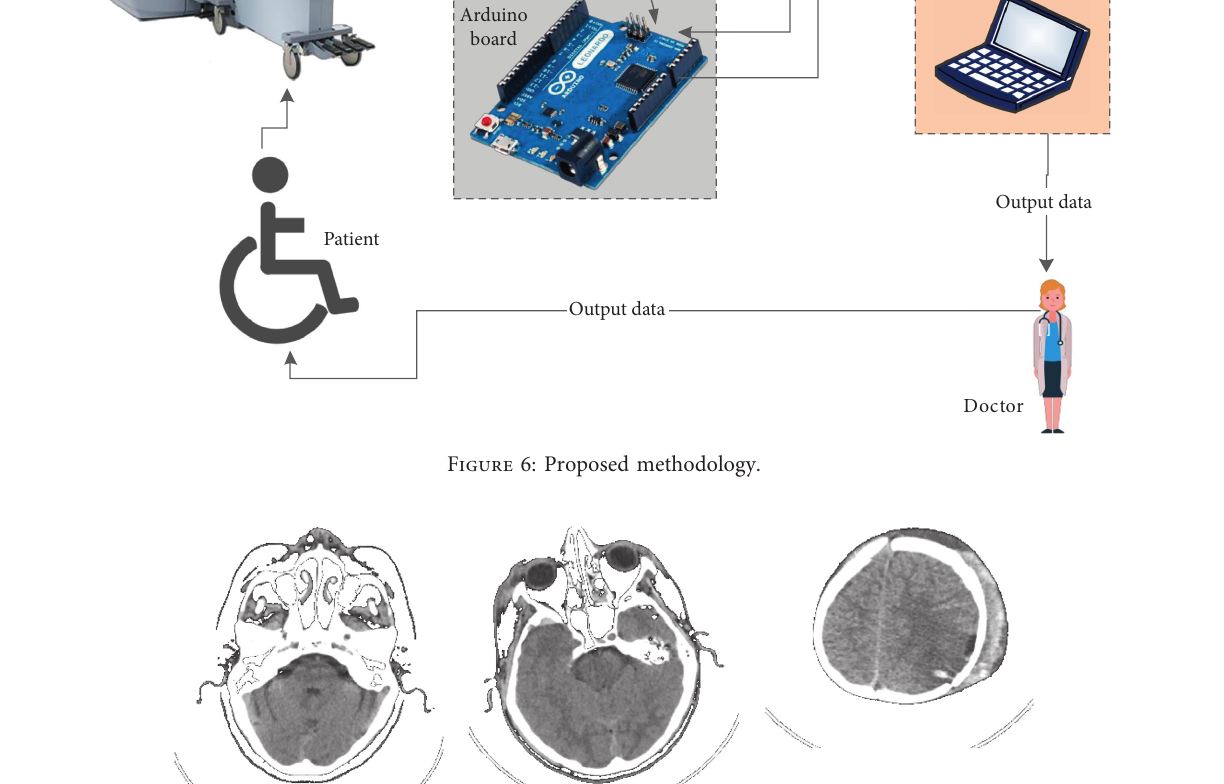
Figure 7: Brain hemorrhage CT scan images: (a) normal, (b) epidural hemorrhage, and (c) intraparenchymal